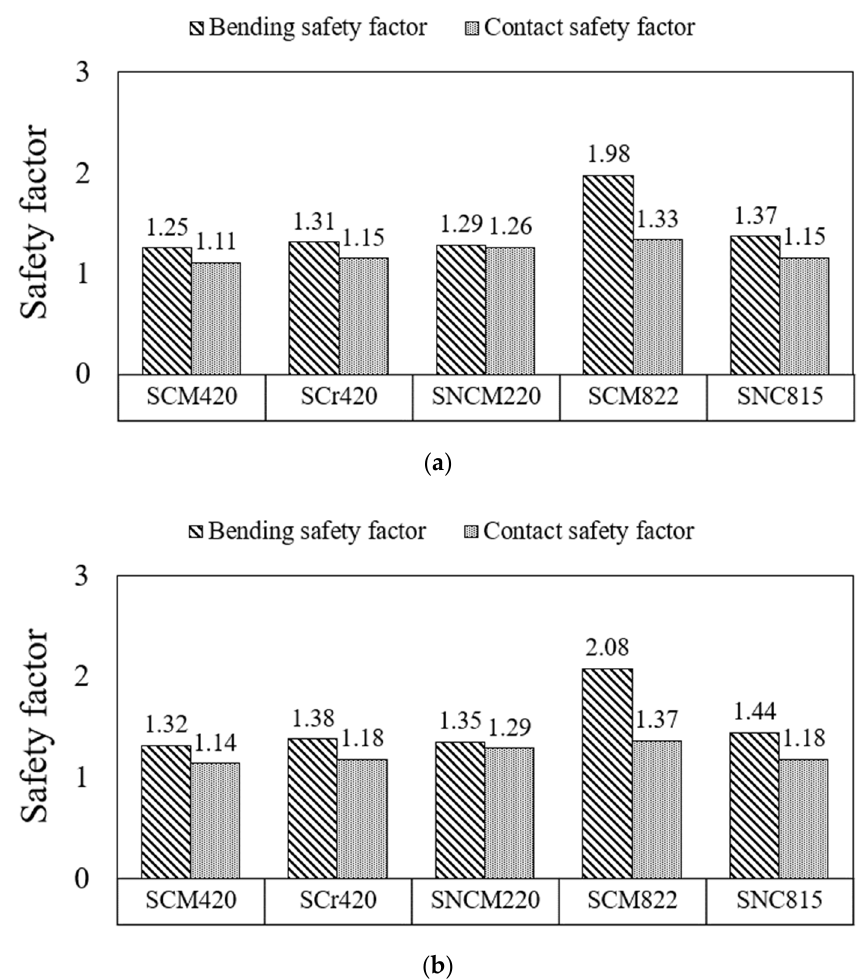
Figure 10. Results of safety factor analyses for the range shift B gears with different materials: ( a ) driving gear; ( b ) driven gear.